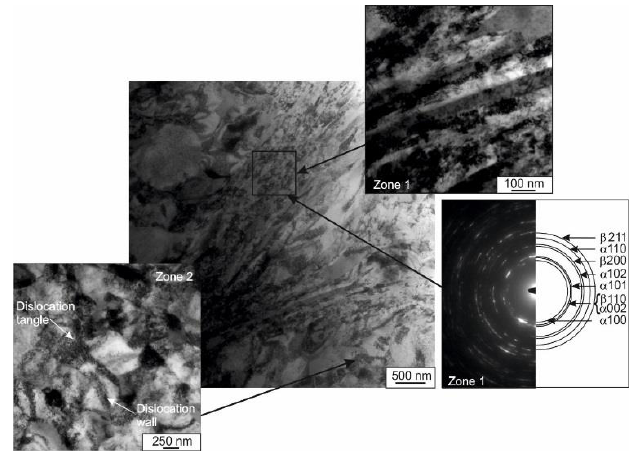
Figure 5. Results of transmission electron microscope (TEM) investigations of the shear bands and adjacent material.